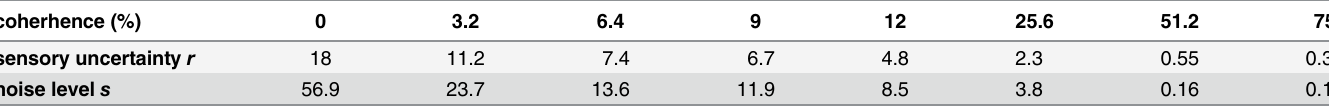
Table 2. Fitted parameter values (best fitting sample for each